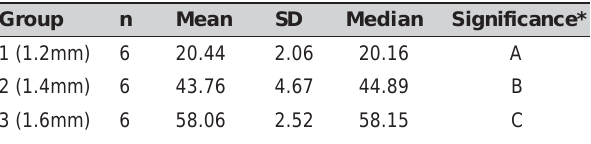
Table 1 - Descriptive statistical analysis of the maximum